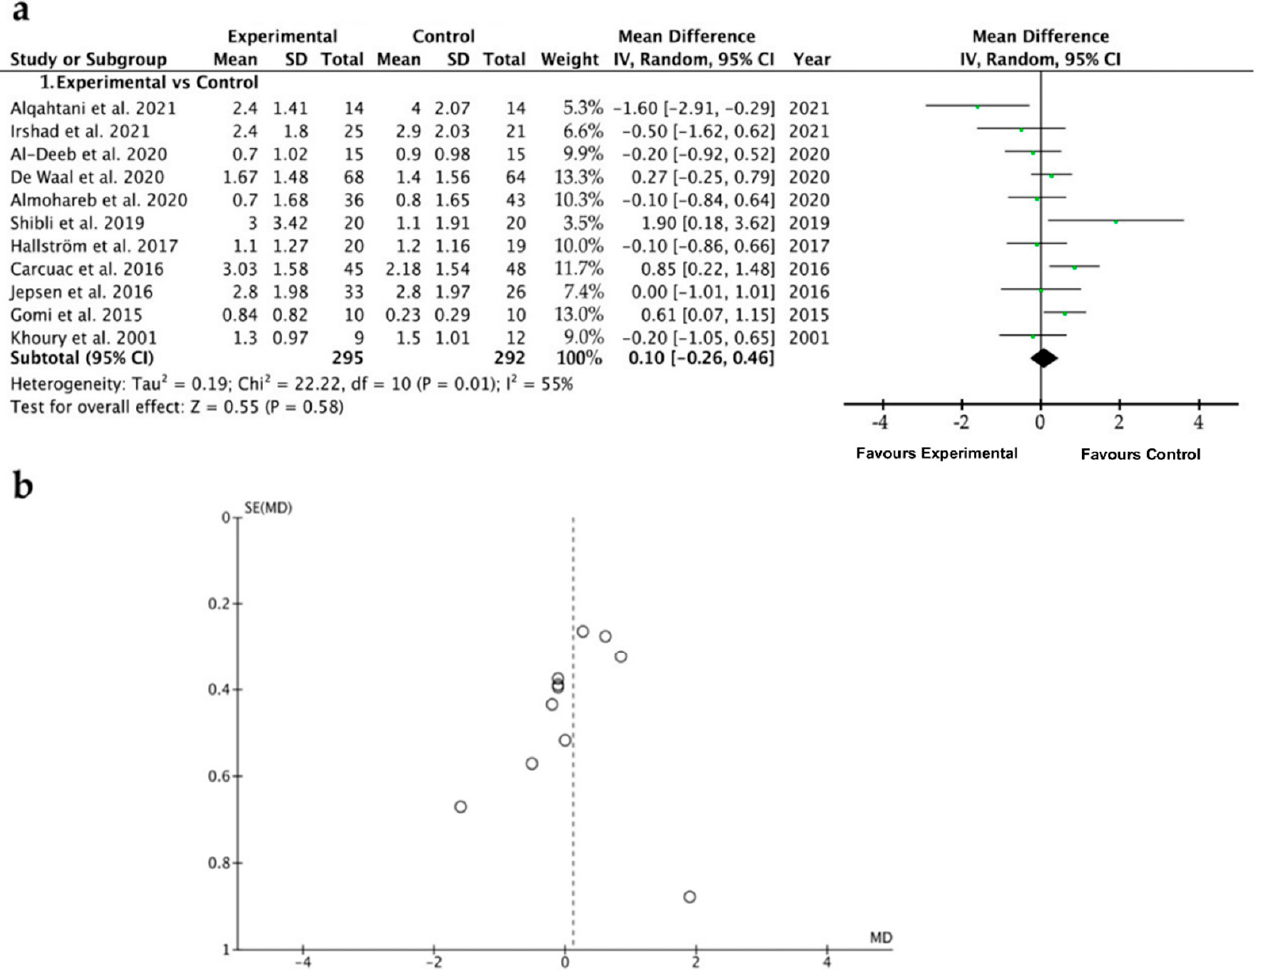
trating the publication bias and the systematic heterogeneity of the included studies. The standard error (SE) is represented in the vertical axis and the probing pocket depth (MD) in the horizontal axis [1,6,17,24,30,48,52,54–57].